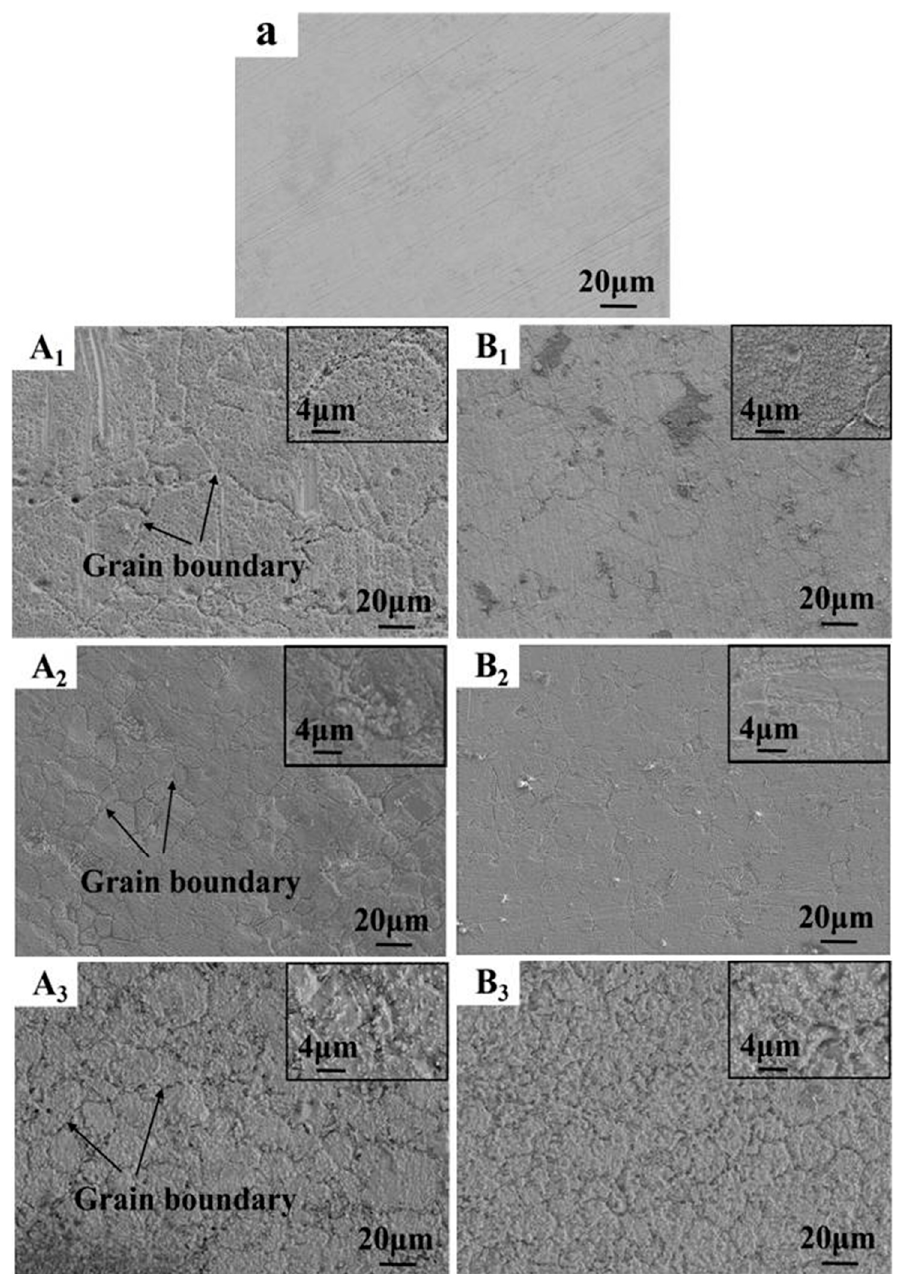
Figure 3. Surface SEM images of original 316SS (a), corroded 316SS exposed in salts A (A 1 , A 2 , A 3 ) and B (B 1 , B 2 , B 3 ) under Ar for 100 h at 500 °C (A 1 , B 1 ),600 °C (A 2 , B 2 ) and 700 °C (A 3 , B 3 ).